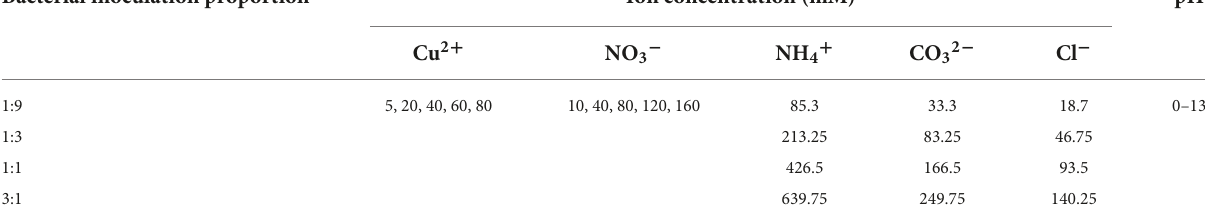
TABLE 1 Parameters applied to the numerical simulations of the copper immobilization efficiency against Cu(NO 3 ) 2 concentration and pH considering bacterial inoculation proportions of 1:9, 1:3, 1:1, and 3:1, respectively. Bacterial inoculation